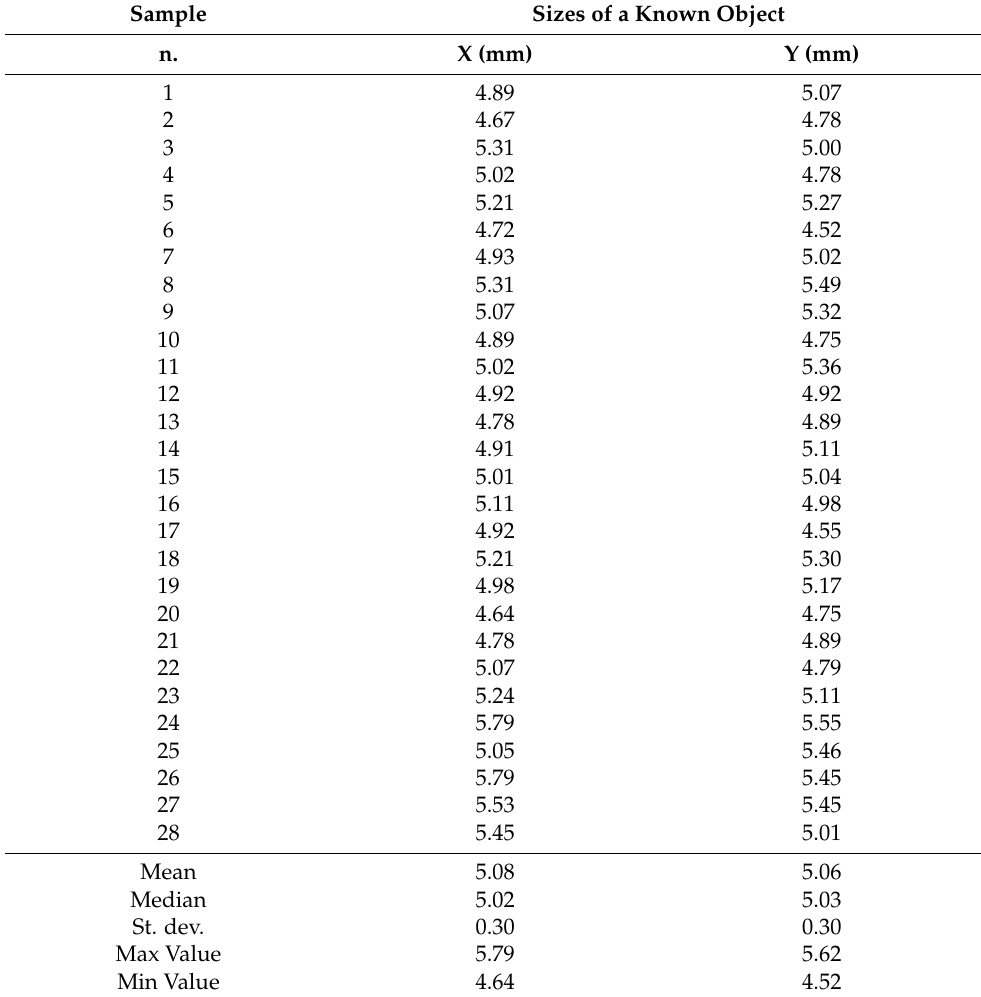
Table 3. Sizes of X and Y calculated by the ML algorithm for an object of known dimension (5 × 5 mm) for a subset of 28 samples. At the end of the table, some statistics calculated for the subset are present. Sample Sizes of a Known Object n. X (mm) Y